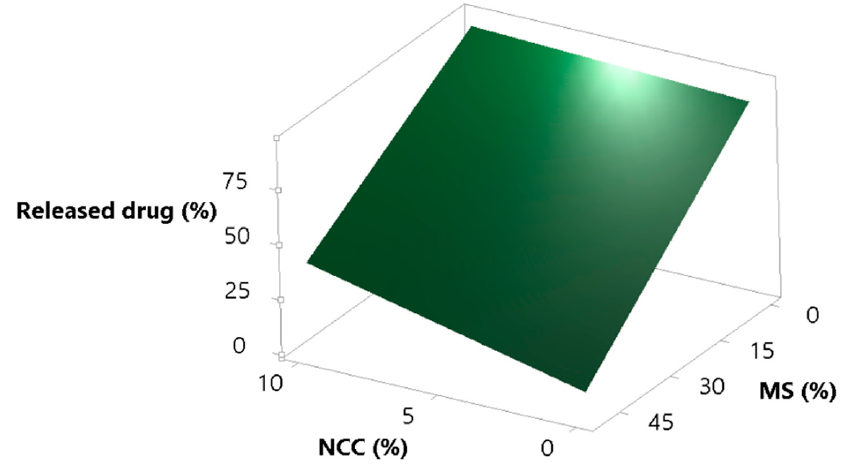
Figure 5. Surface plot for the response percent of released drug in the supernatant; effect of NCC and MS concentration.